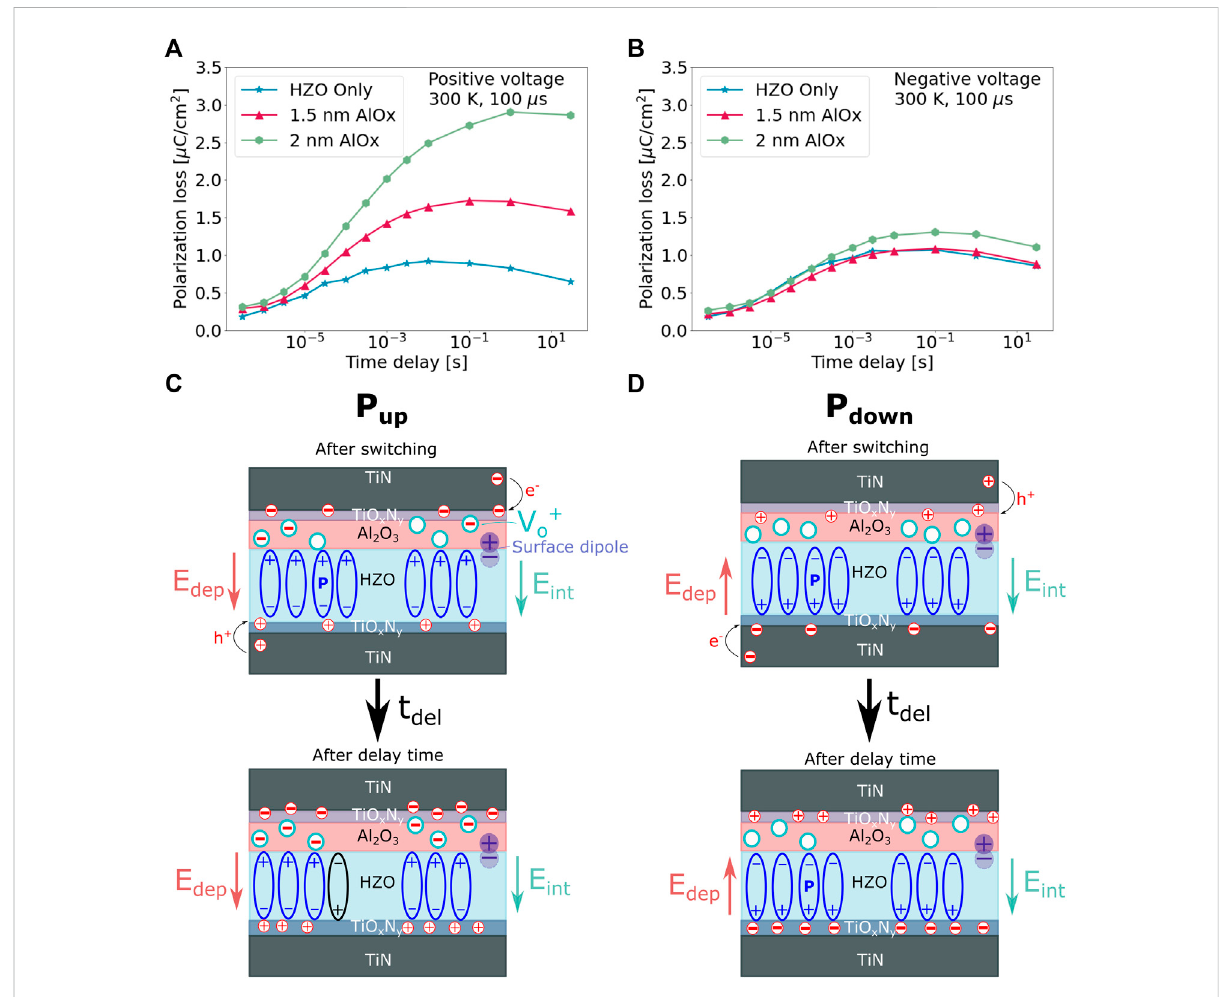
FIGURE 3 Polarization loss (P loss ) as a function of the delay time under no external bias (t del ) for (A) positive polarity (P up state) and (B) negative polarity (P down state). Voltage amplitudes are 3.5 V (HZO only), 5.5 V (1.5 nm Al 2 O 3 ), 6 V (2 nm Al 2 O 3 ). Schematic depictions of the movement of charges within the stack for (C) the P up state and (D) the P down state, during the delay